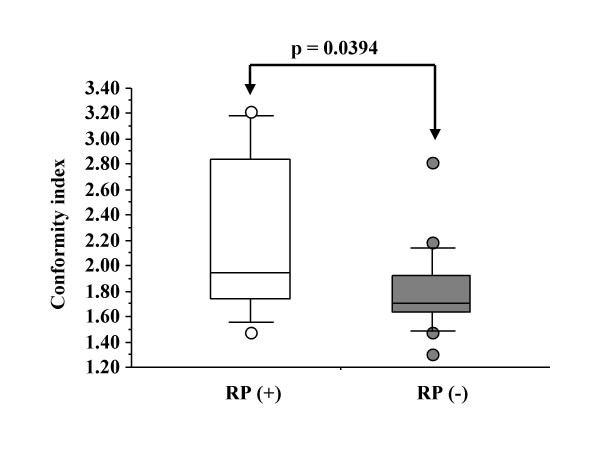
The correlation comparing the occurrence of RP grade 2 or more with CI.